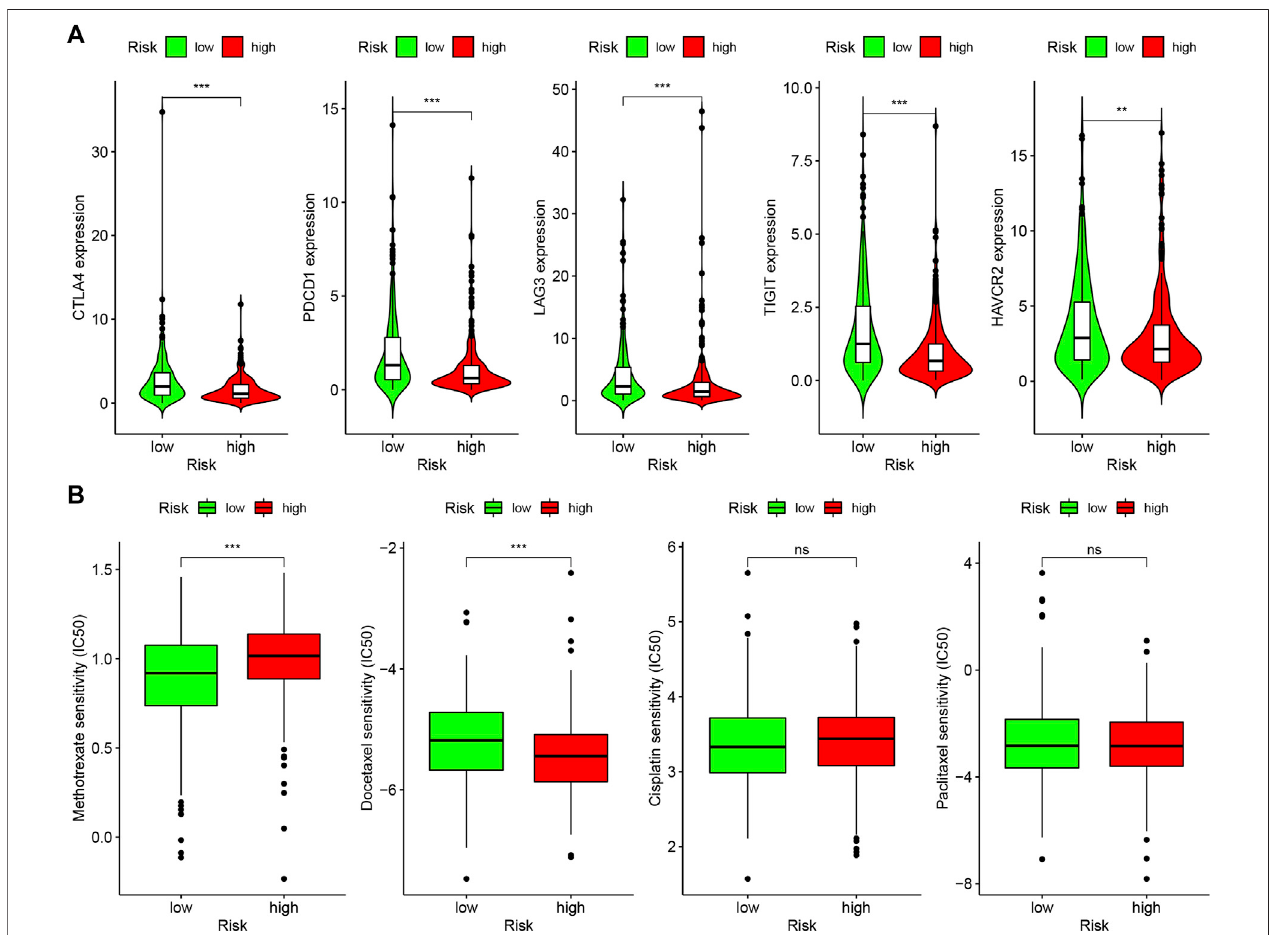
FIGURE6| Differences ofcheckpoint-related geneexpression and chemotherapeutic sensitivity inhigh- and low-risk groups. (A) Thehigh-risk groupin themodel was negatively associated with CTLA-4, PDCD1, LAG3, TIGIT, and HAVCR2. (B) The high-risk group in the model was related to lower IC50 of chemotherapeutics of methotrexate, and the low-risk group was related to lower IC50 of chemotherapeutics of docetaxel, whereas, in high- and low-risk groups, there were no statistical differences for cisplatin and caclitaxel.